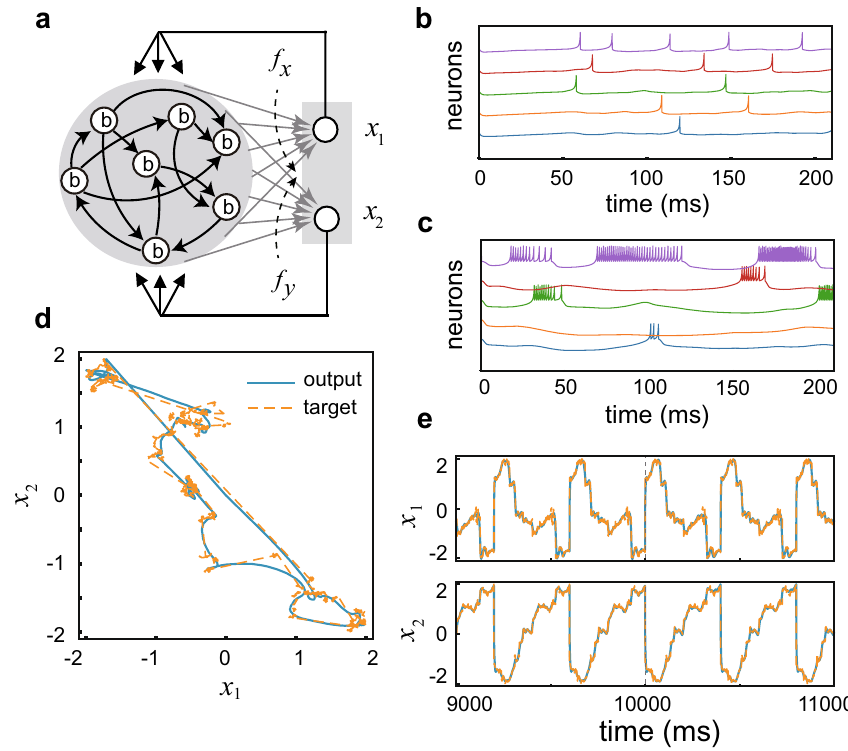
Figure 1. The architecture and basic performance of the model. ( a ) The present RC system consists of a reservoir and two readout neurons. ( b , c ) Before learning, neurons in the reservoir tend to show isolated spikes in the RS mode ( b ) or intrinsic bursts in the bursting mode ( c ). Here, the firing patterns were simulated at G = 50 . ( d ) A typical example of the target trajectories representing a finite portion of two-dimensional Lévy flight (orange) and the learned responses of the readout neurons (blue). ( e ) The time evolution of the two readout neurons are shown as functions of time. The target signal was lifted after the time point indicated by the vertical dashed line. Large discontinuous jumps in ( d ) and ( e ) indicate the start and end points of the repeated target signal. These jumps were not included in the target signal and hence not learned by the